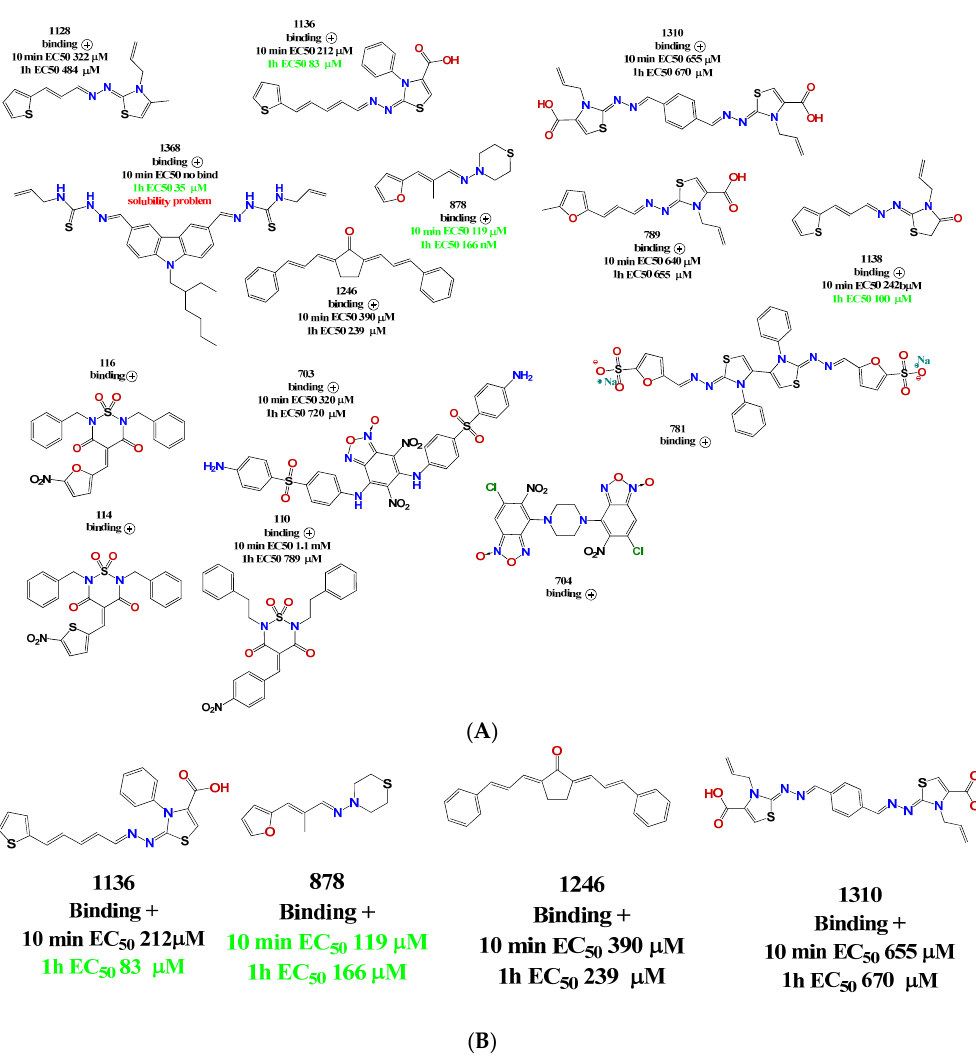
Figure 5. ( A ) Compounds binding to CA identified in the MST screening. With each structure are the binding data and the EC 50 values; ( B ) Verified hits in the polymerization assay. binding data and the EC 50 values; ( B ) Verified hits in the polymerization